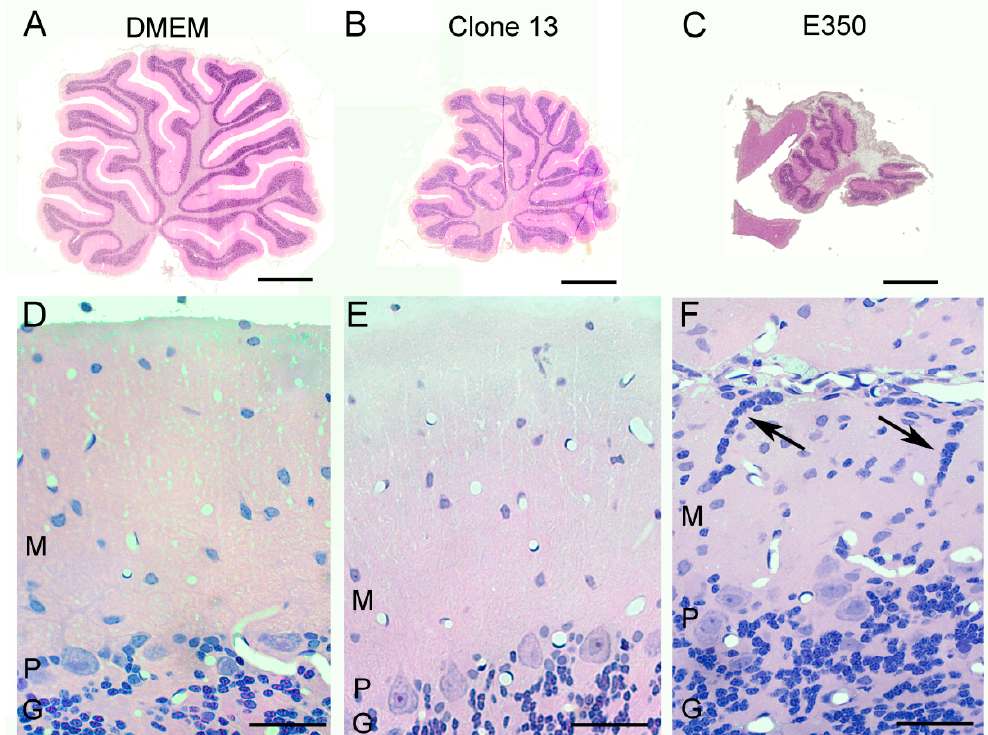
Figure 6. Strain E350, but not the other strains, induced a neuronal migration defect. Pictured here are 4-micron-thick, hematoxylin and eosin-stained, midsagittal cerebellar sections at low power ( A–C ) and high power ( D–F ) from rats on PD22. ( A ) The uninfected control cerebellum consists of ten lobules. ( D ) The normal cerebellar cortex consists of a cellular granule cell layer ( G ), Purkinje cell layer ( p ) in which large Purkinje cell bodies reside, and an outer molecular layer ( M ) in which cells are relatively sparse. ( B ) The Clone 13-infected cerebellum is markedly reduced in size (hypoplastic), but has no destructive lesions. ( E ) The cerebellar cortex of Clone-13-infected animals is histologically normal. ( C ) The E350-infected cerebellum is markedly abnormal, as it is greatly reduced in size and has large areas of encephalomalacia. ( F ) The cerebellar cortex of E350-infected animals is abnormal, with the presence of clusters of granule cell neurons (arrows) ectopically located within the molecular layer. These cells failed to migrate properly through the molecular layer to the internal granule cell layer. Scale bars represent 1 mm in A – C and 50 um in D – F .